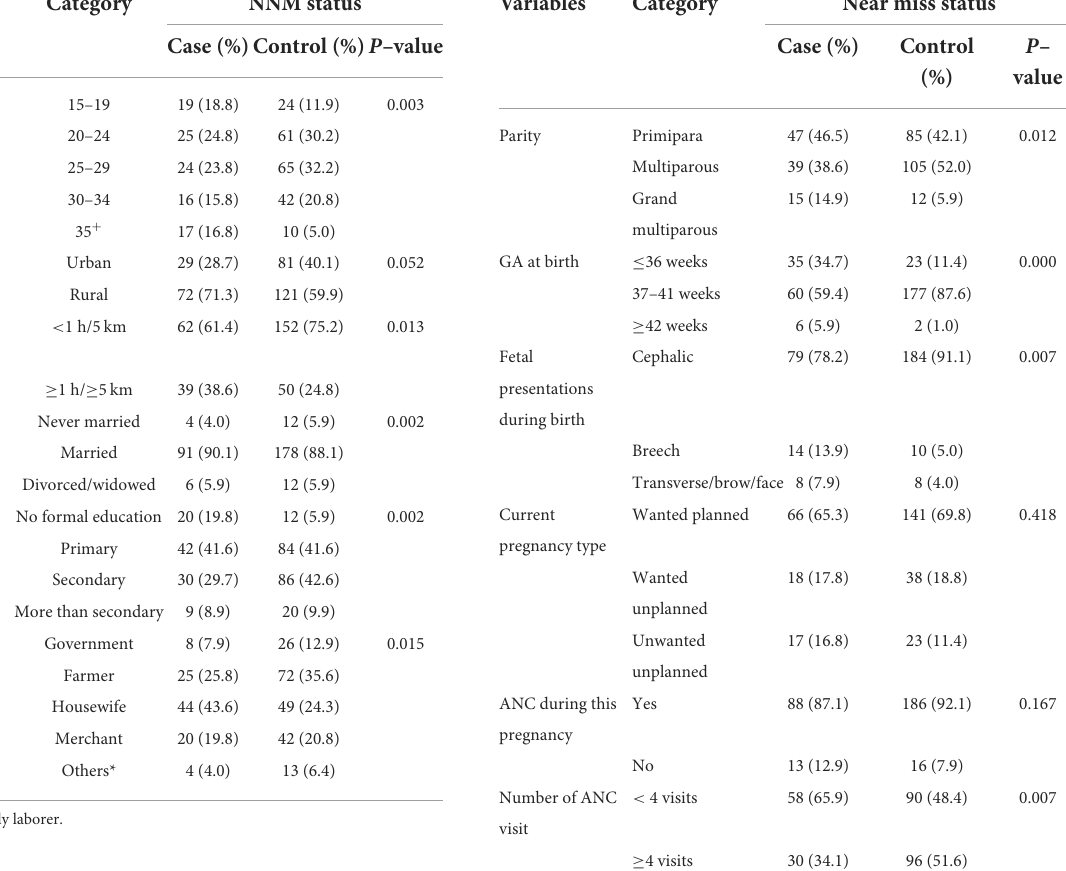
TABLE 2 Socio-demographic characteristics of mothers of neonates admitted ( n = 303) to public hospitals of Ilu Abba Bor Zone, 2020. Variable Category